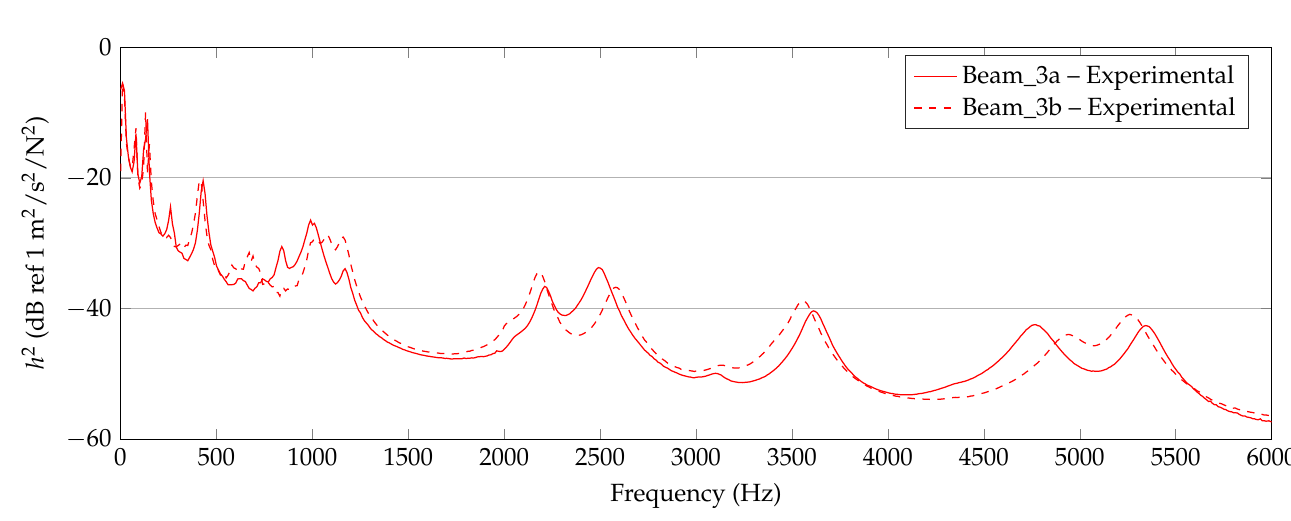
Figure 6. Experimental results of 6mm beam measurements (Beam_6a, Beam_6b).